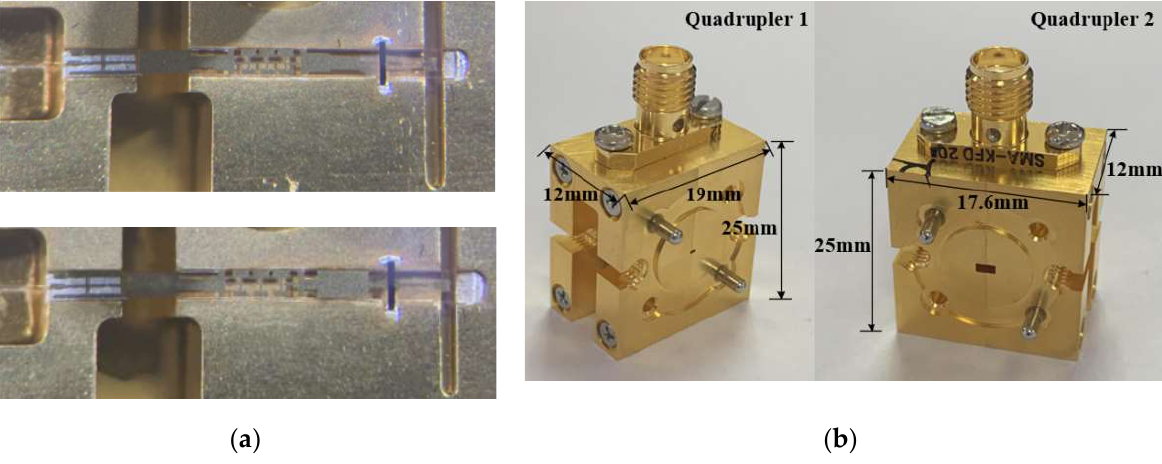
Figure 6. ( a ) Circuits in the quadrupler blocks; ( b ) photographs of the entire quadrupler modules.